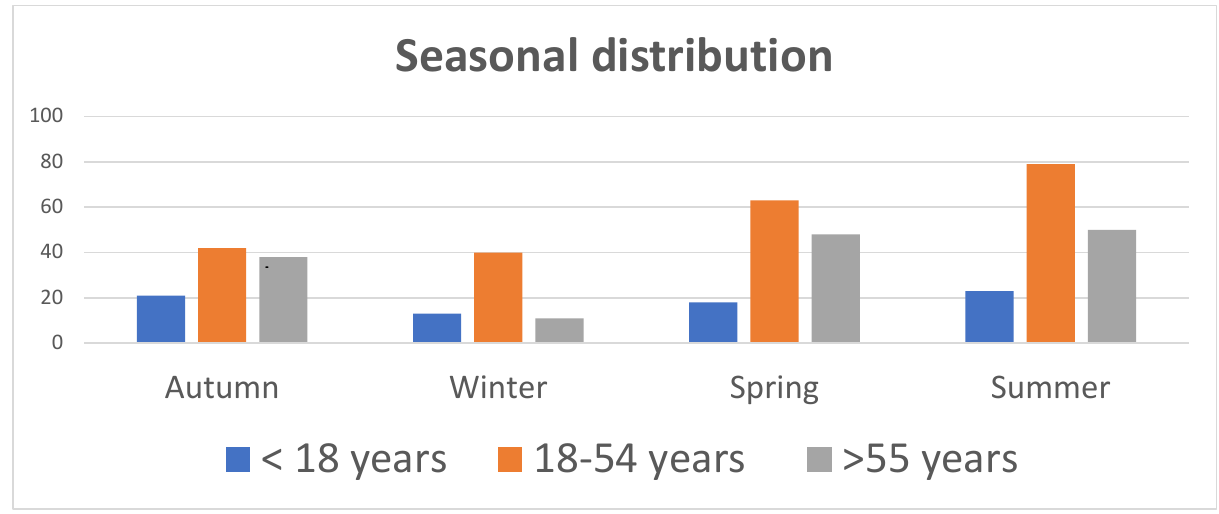
Figure 2. Seasonal distribution among the three age groups.